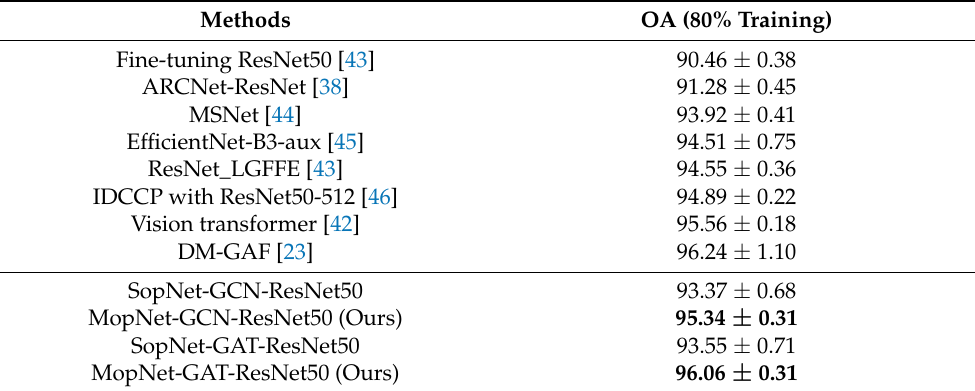
Table 3. Comparison of OAs (%) on the OPTIMAL-31 dataset.